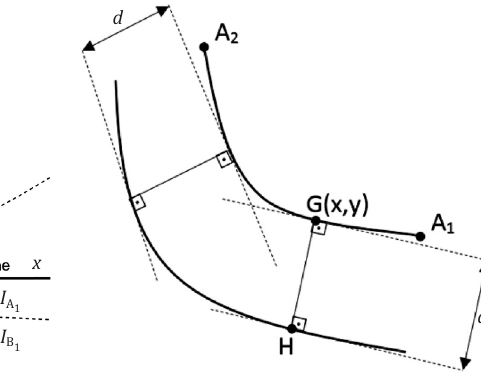
Figure 9. Direct left-turn lane 1 and A 2 (by G.